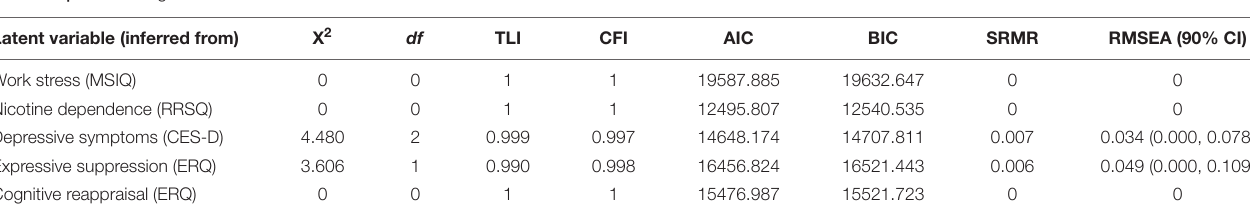
TABLE 4 | Model fitting information for the measurement model.